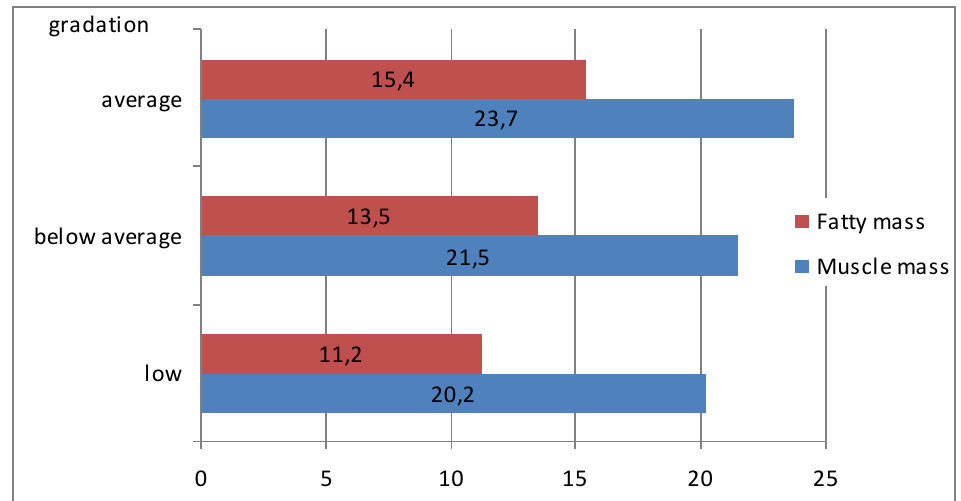
Fig. 1. Muscular and fatty body structure (kg) of females with different gradation of body mass parameter